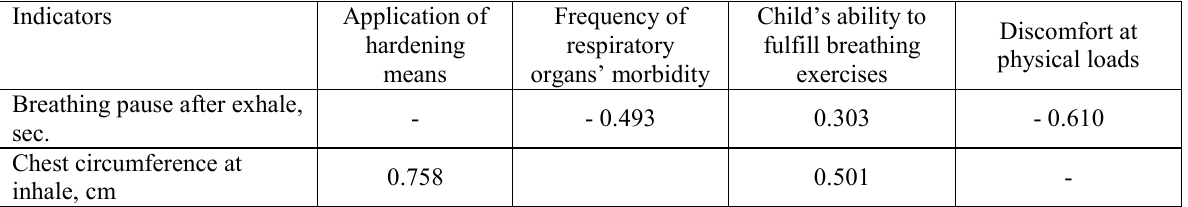
Estimation of some respiratory system indicators’ dependence on 7-9 years old children’s life style with